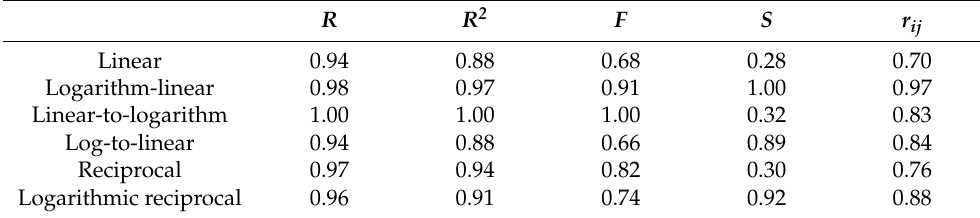
Table 7. Measured value of each target effect.